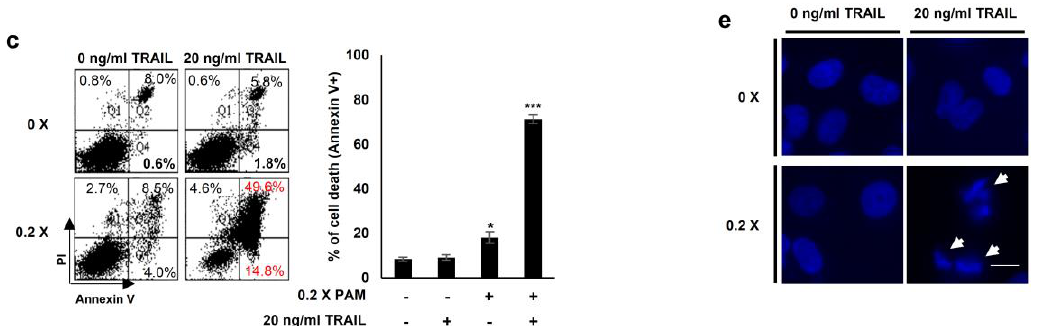
Figure 1. PAM and tumor necrosis factor-related apoptosis-inducing ligand (TRAIL) synergistically induce cancer cell death. ( a ) Preparation of plasma activated medium (PAM) using a non-thermal plasma generator system. PAM was generated by exposing DMEM or RPMI-1640 medium to non-thermal plasma jet at a distance of approximately 2 cm. ( b ) HeLa cells were treated with TRAIL at various concentrations (10 to 100 ng / mL) in the absence or presence of serially diluted PAM as indicated. Cell viability was assessed after 24 h of treatment using the MTT assay. * p < 0.05, ** p < 0.01, *** p < 0.001. ( c ) Cell death was analyzed using fluorescence-activated cell sorting (FACS) following Annexin V and propidium iodide (PI) staining. Left panel shows a representative image of necrosis and early and late apoptosis. Right panel shows statistical analysis of cell death. * p < 0.05, *** p < 0.001). ( d ) PAM promoted TRAIL-mediated apoptosis. Immunoblotting was performed using antibodies directed against cleaved caspase 3, PARP, and actin. ( e ) Condensation and fragmentation of the nuclei were detected via 4′,6-diamidino-2-phenylindole (DAPI) staining. Arrows: fragmented nuclei. Scale bar: 10 μm.